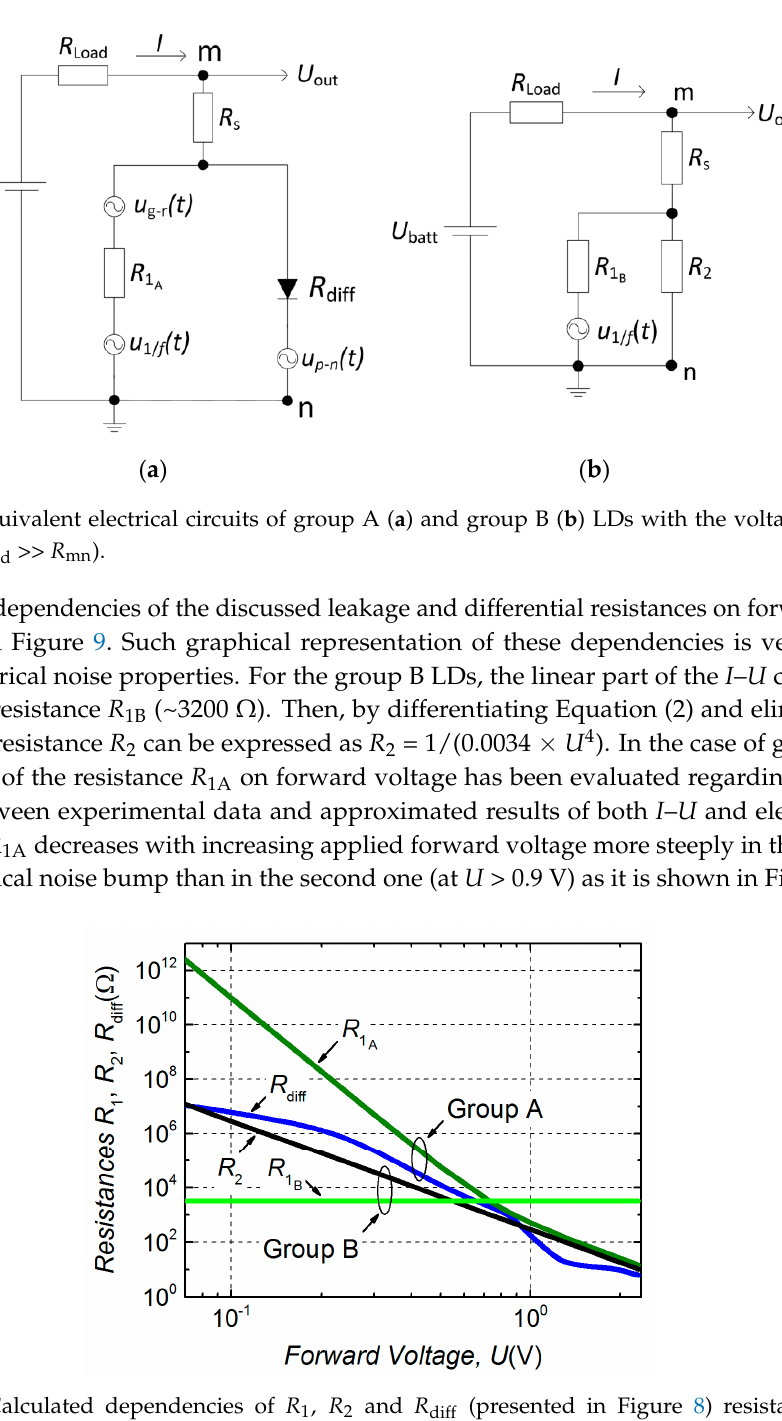
Figure 9. Calculated dependencies of R 1 , R 2 and R diff (presented in Figure 8) resistances on forward voltage.